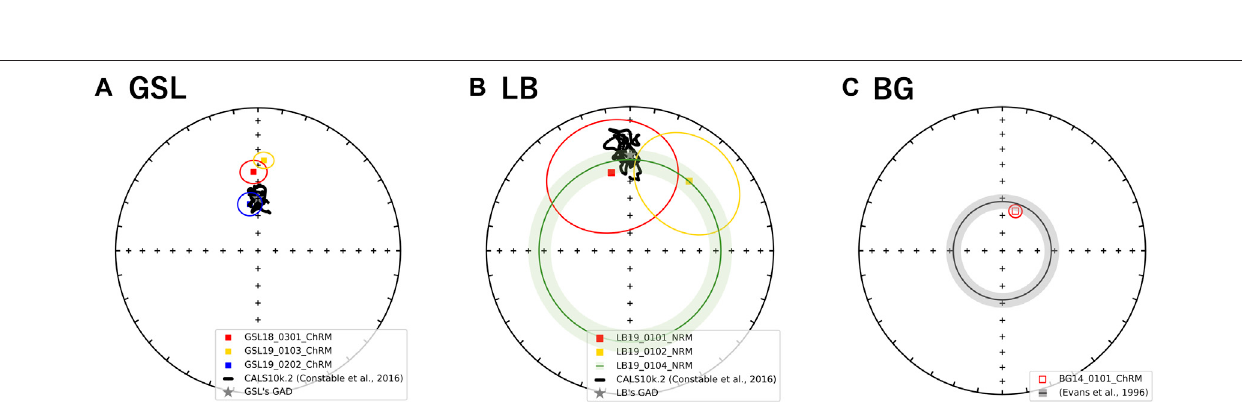
FIGURE 7 | Equal area stereographic projection of magnetization components observed from (A) GSL (B) LB, and (C) BG samples. The mean declination and inclination with α 95 ellipses of NRM or ChRM. Where declination was not available (LB19_0104) mean inclination is shown as a circle around the center with α 95. Open and closed symbols represent directions in the upper and lower hemisphere, respectively. A gray star in (A) GSL (B) LB panel represents GAD value of each site. The black line on GSL and LB stereographic projections represent the CALSk10.2 model based on the latitude and longitude of GSL sampling site from 10 ka to present (Constable et al., 2016). The gray shading annulus on the BG panel (inclination: − 62 ± 4 ° ) represents the expected directions derived from sedimentary beds in the same formation (Evans et al., 1996).